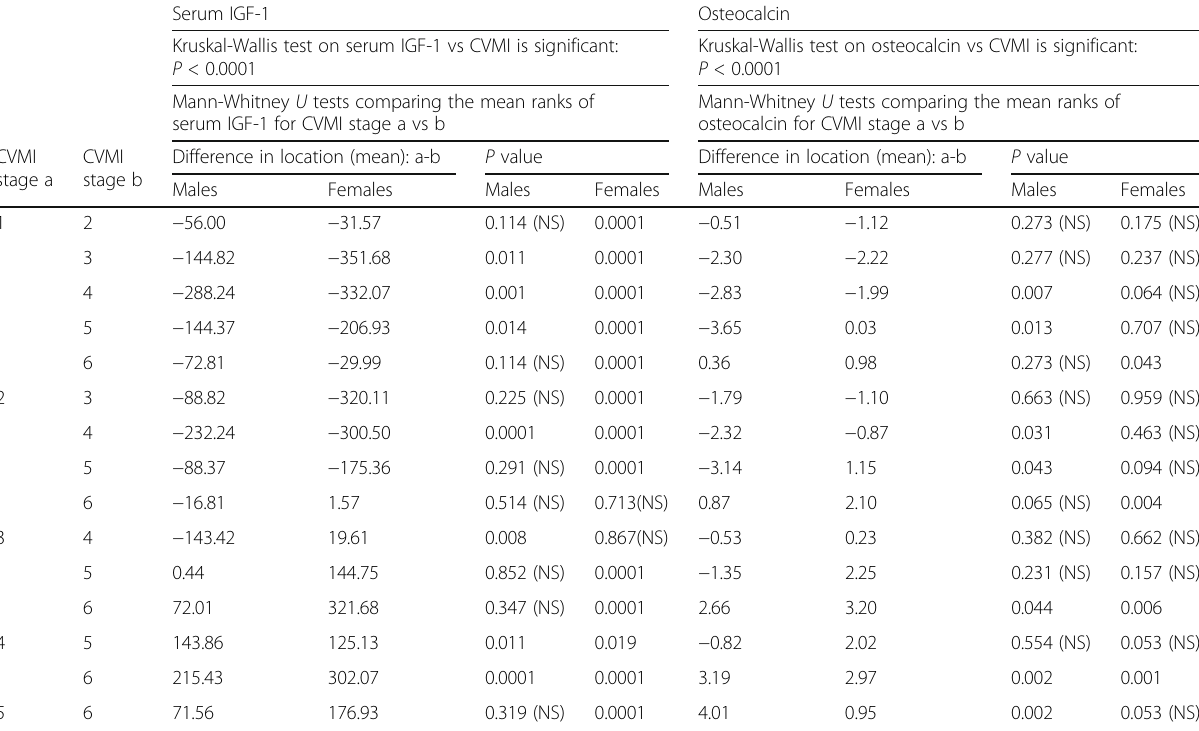
Table 3 Kruskal-Wallis and Mann-Whitney U tests comparing each CVMI stage in males and females for serum IGF-1 and serum Osteocalcin Serum IGF-1